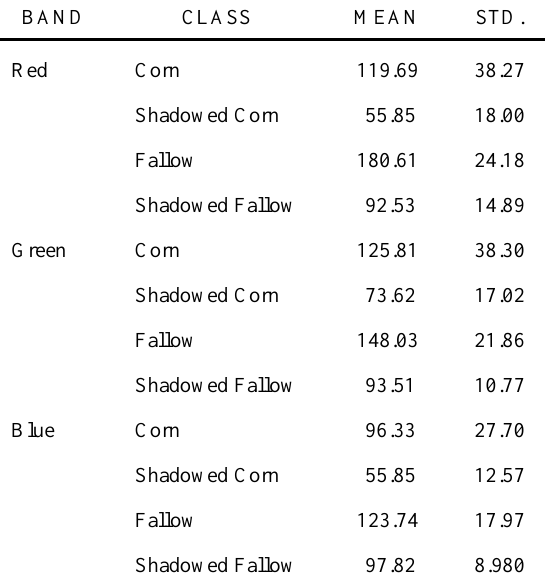
Table 4. The mean and standard deviation of the shadow